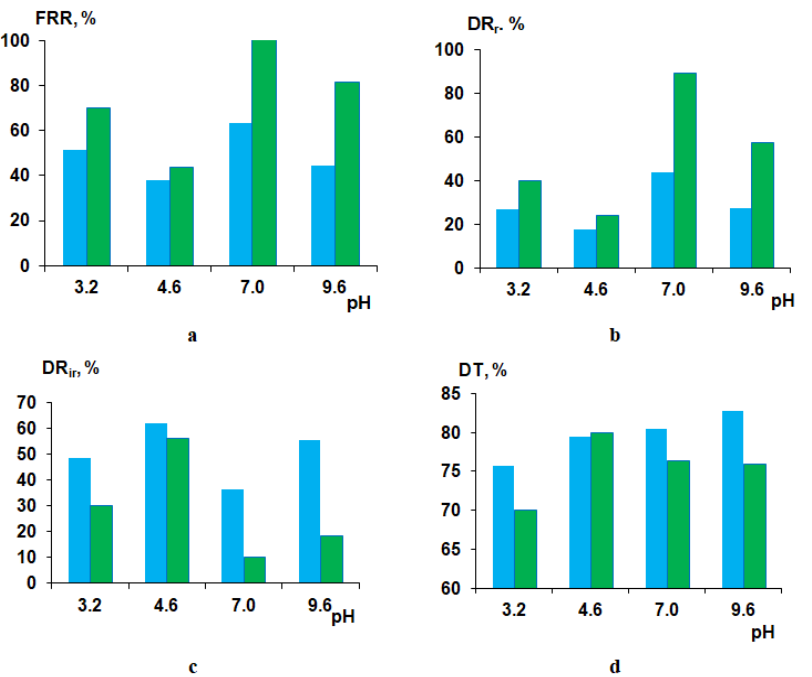
Figure 14. Fouling parameters of PSF60 (blue color) and B-0.1-60 (green color) membranes at different pH upon HSA solution ultrafiltration: ( a ) flux recovery ratio (FRR); ( b ) reversible flux decline ratio (DR r ); ( c ) irreversible flux decline ratio (DR ir ); ( d ) total flux decline ratio (DT).